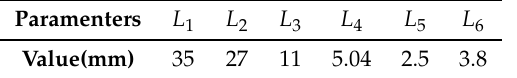
Table 2. The parameters of the GPS/GLONASS antenna.